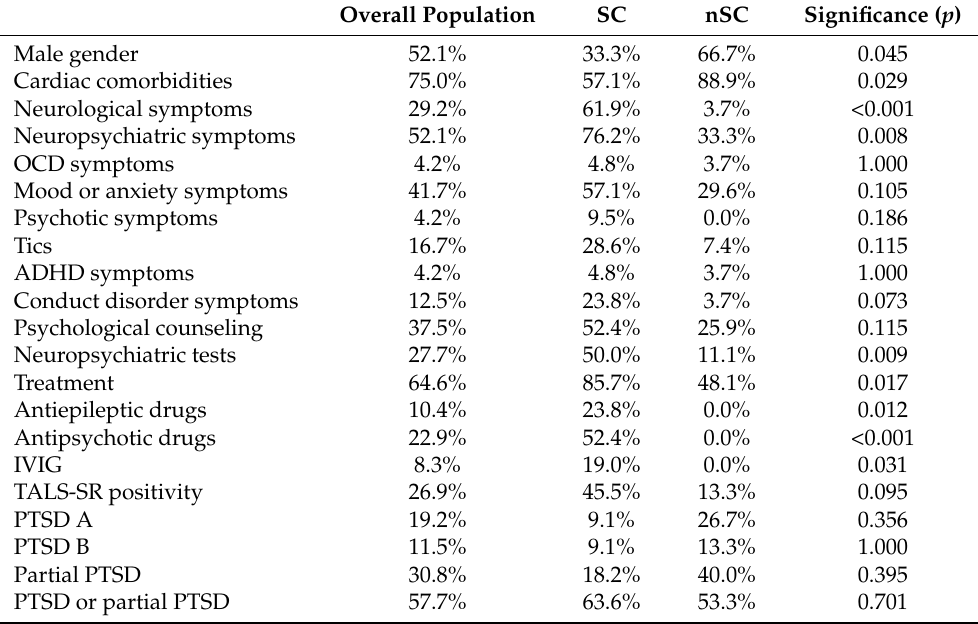
Table 3. Descriptive study cohort table, showing the presence of several investigated variables in the overall population (n = 48), in SC patients (n = 21) and in nSC patients (n = 27). Significance calculated by the execution of chi-square tests of independence is also